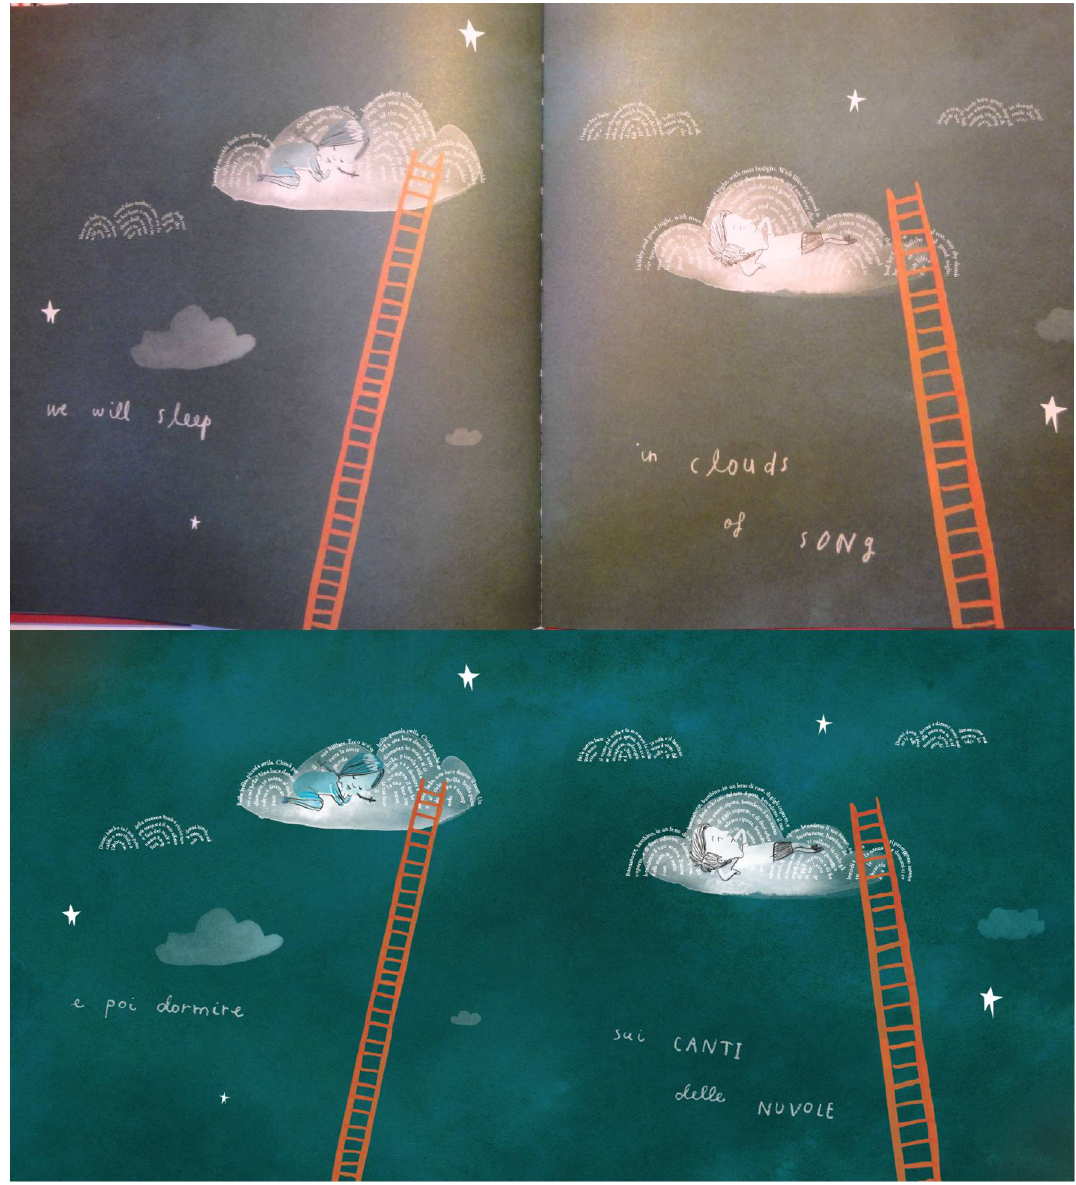
Figure A18. Jeffers O.; Winston S. A child of books, Walker Books, London, 2016; Jeffers O.; Winston S. La bambina dei libri, Lapis, Roma,